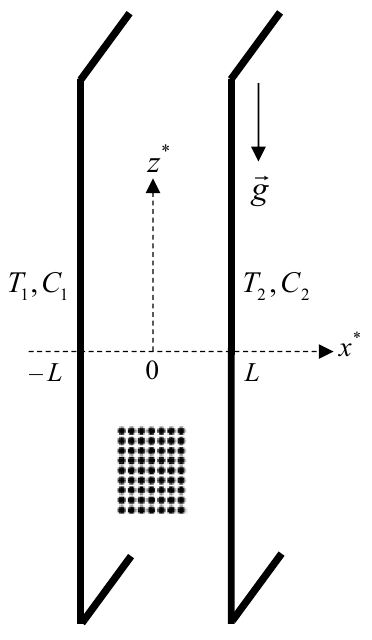
Figure 1. A sketch of the vertical porous